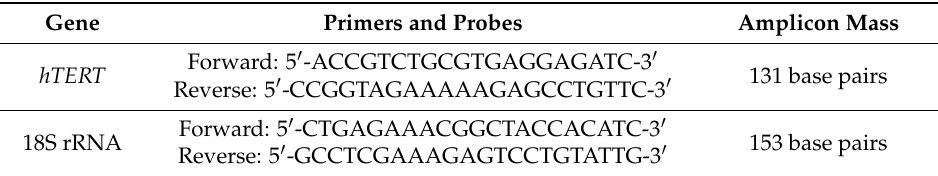
Table 1. Sequences and probes used for polymerase chain reaction (PCR) to measure hTERT expression in Jurkat T